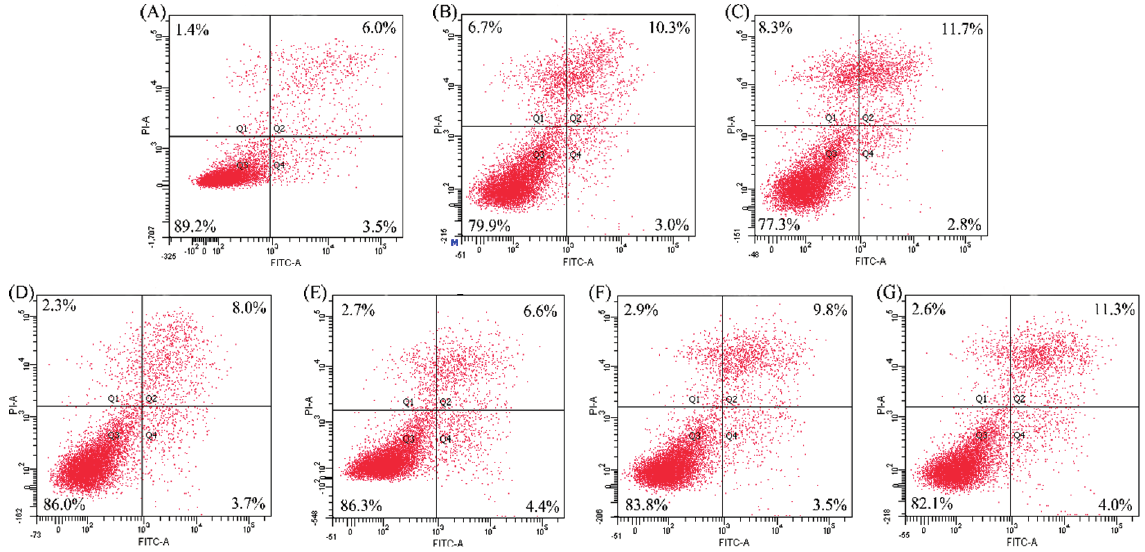
Figure 4. Apoptotic reversal of casein and soy protein hydrolysates (CH3 and SH3) at 0.05 mg/mL on etoposide- and NaF-induced apoptosis of hFOB1.19 cells. Cell apoptosis was measured by Annexin FITC-V/PI double-stained flow cytometry. Q1, dead cells; Q2, later apoptotic cells; Q3, viable cells; Q4, early apoptotic cells. ( A ) The cells in control group; ( B , C ) The cells treated by etoposide and NaF, respectively; ( D , F ) The cells first treated by etoposide, and then by CH3 and SH3, respectively; and ( E , G ) The cells first treated by NaF, and then by CH3 and SH3, respectively. The labeled data were obtained from one assaying